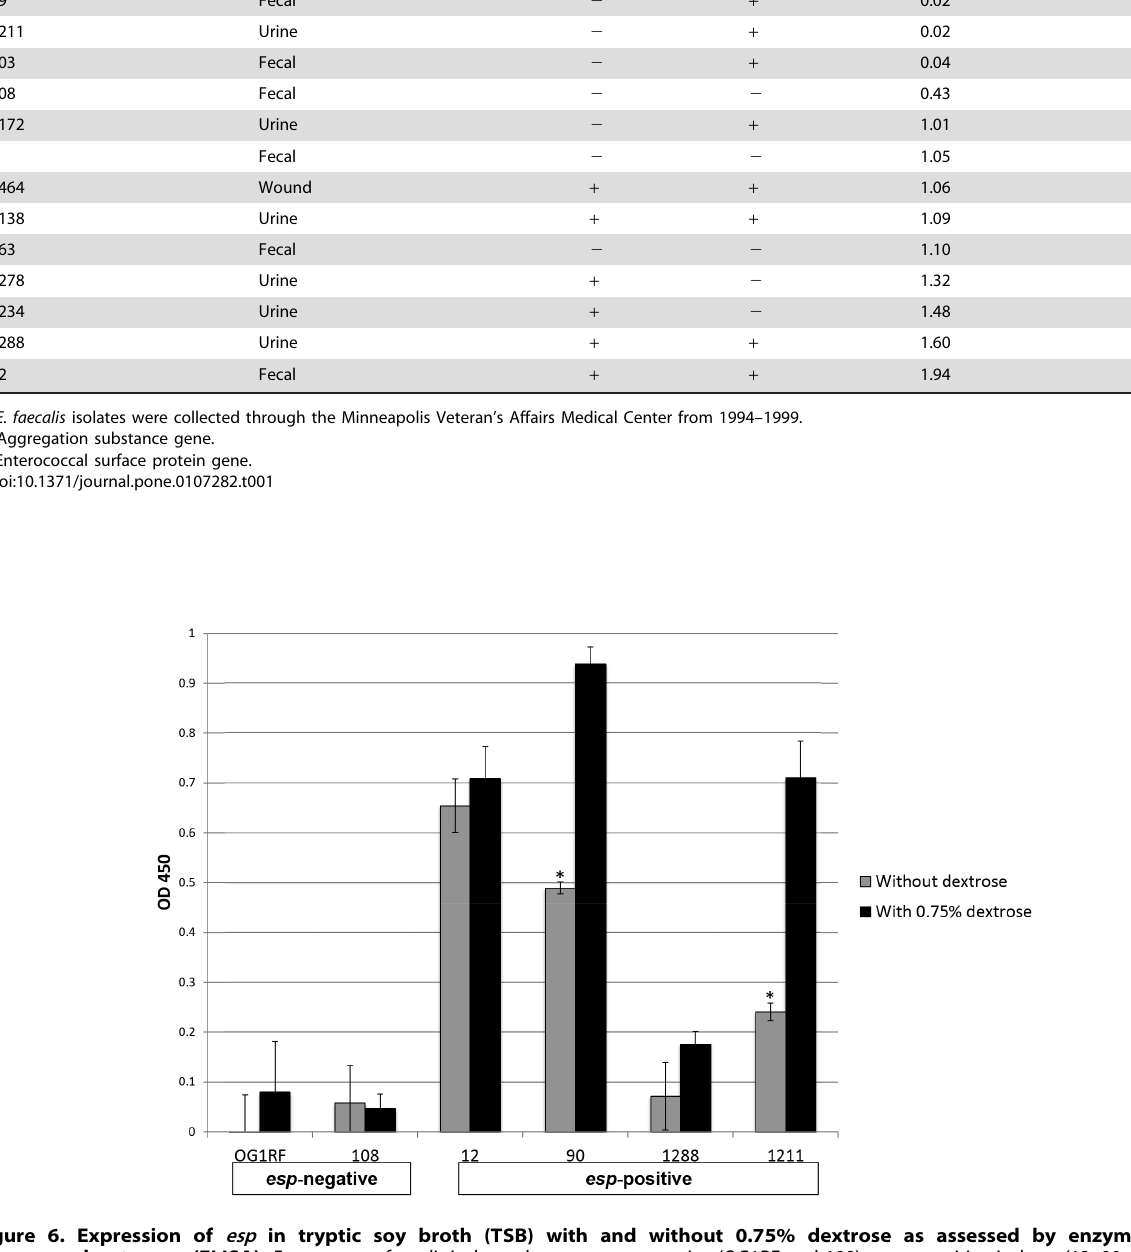
Figure 6. Expression of esp in tryptic soy broth (TSB) with and without 0.75% dextrose as assessed by enzyme linked immunosorbent assay (ELISA). Enterococcus faecalis isolates that were esp -negative (OG1RF and 108) or esp positive isolates (12, 90, 1288, and 1211) were assessed by ELISA for esp expression after growth in TSB without dextrose and TSB supplemented with dextrose (0.75% dextrose). The ELISA was repeated in duplicate with reproducible results. Some background signal, as seen in OG1RF and 108, is expected due to non-specific binding. Error bars represent standard deviation. *indicates p , 0.05 for comparison of esp expression with and without dextrose. doi:10.1371/journal.pone.0107282.g006 PLOS ONE |